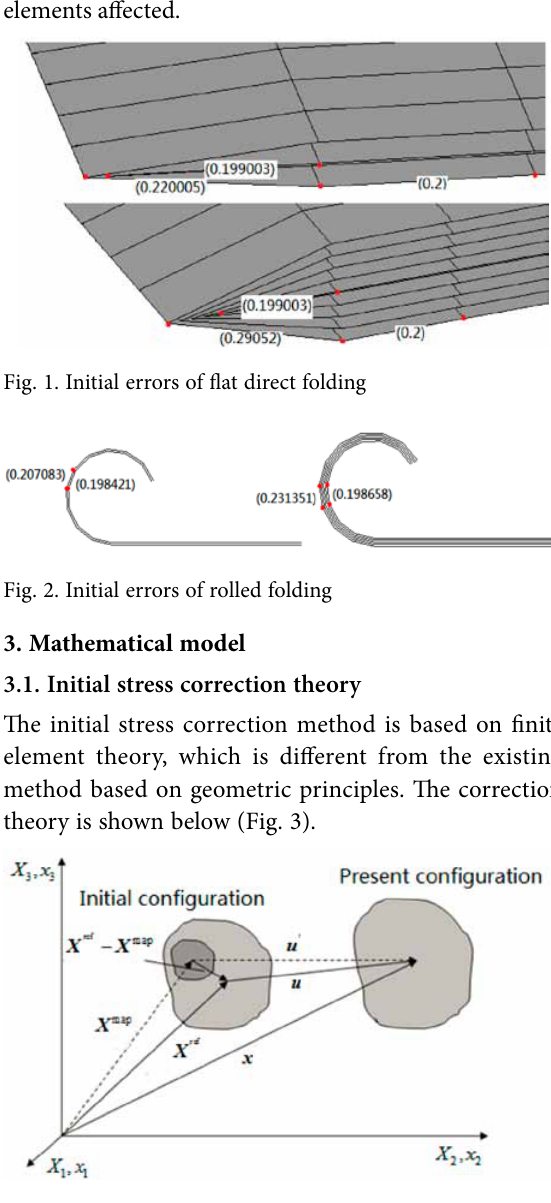
Fig. 3. Replacement of the initial configuration Fig. 4. Steps of initial stress